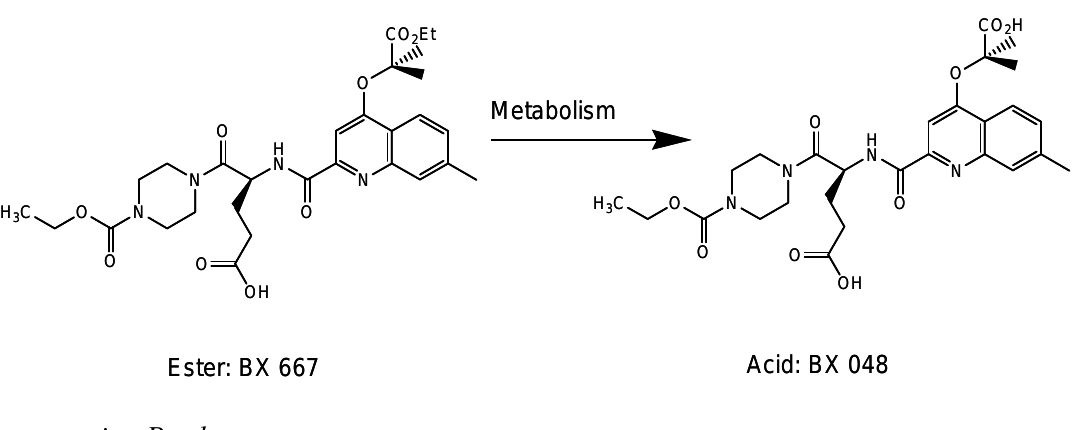
Figure 5. Chemical structure of BX667 and BX048 (adapted from [27]).